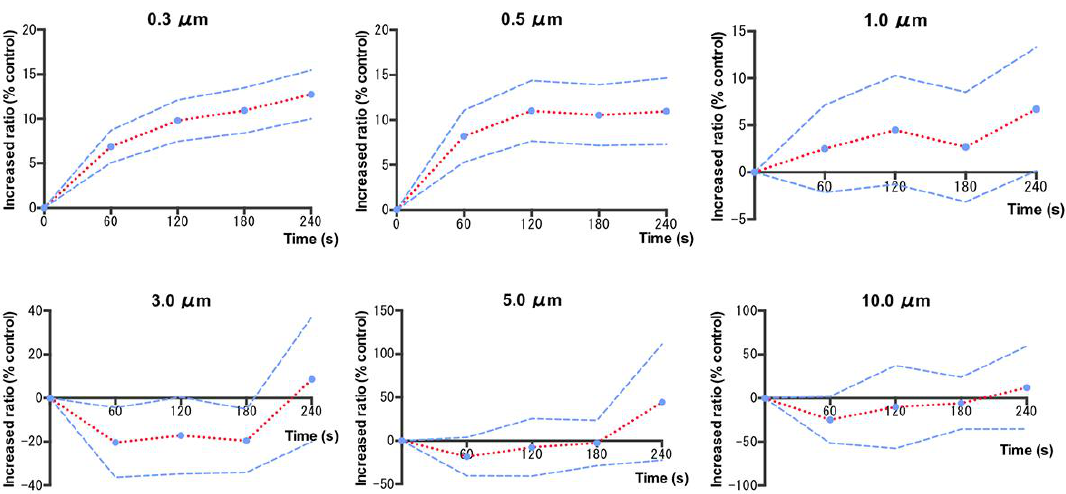
Figure 3. Percentage increase in aerosol particles of 0.3, 0.5, 1, 3, 5, and 10 μm in size at 60, 120, 180 and 240 s from the start of esophagogastroduodenoscopy (n = 54). The lines represent the mean particle count (0.3, 0.5, 1, 3, 5, and 10 μm) of the 54 patients using the extraoral suction device. The blue dotted line indicates the 95% confidence interval.